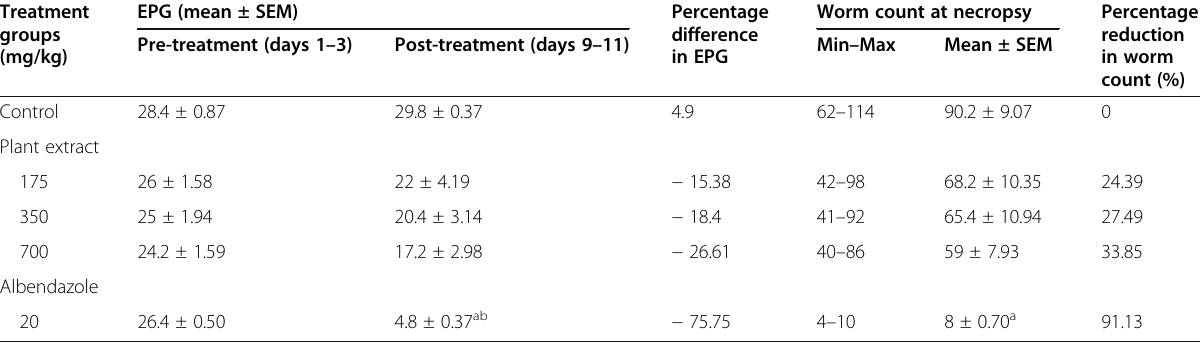
Table 2 In vivo anthelmintic effect of C. compressus methanolic root extract* on S. obvelata in mice Treatment